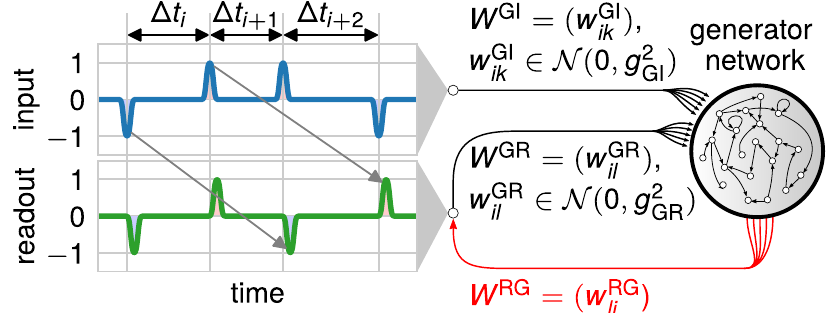
Figure 1. Setup of the benchmark N -back task to test the capability of transient networks to cope with variances in the input timings. The input signal is composed of smooth either positive or negative pulses separated by time 2 . It is projected into the intervals Δ t i drawn from a normal distribution with mean μ Δ t and variance σ ∆ t generator network via a synaptic weight matrix W GI with elements w ikGI drawn from a normal distribution with zero mean and variance g GI2 . The task is to produce an output pulse of defined shape (at the readout neurons) when a new input pulse is presented. The sign of the output pulse depends on the second last input pulse (compare arrows). The readout weight matrix W RG is adapted during learning (red). The resulting readout signal is fed back into the network with a weight matrix W GR with elements w ilGR drawn from a normal distribution with zero mean and variance g GR2